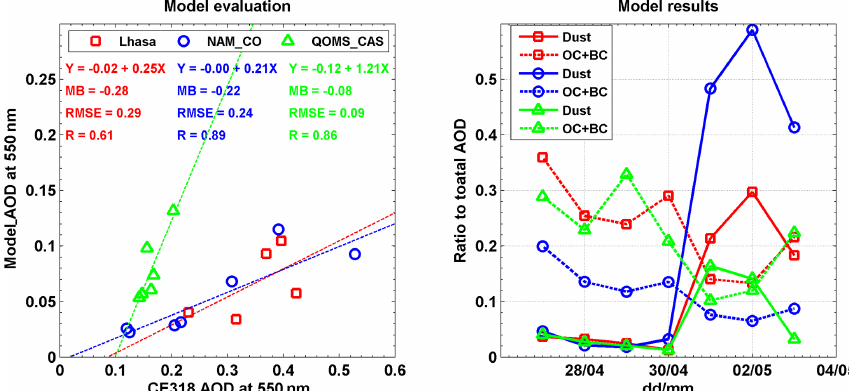
Figure 14. The model evaluation of the GEOS-Chem model simulated the daily average AOD (Model_AOD) by using the CE318-observed daily AOD (CE318_AOD) at 550nm and the model results of the ratios of dust or organic carbon (OC) and black carbon (BC) aerosol to the total AOD during 27 April–3 May 2016 at Lhasa, NAM_CO and QOMS_CAS. The statistical parameters used in the modal evaluation are the same as those in Fig.